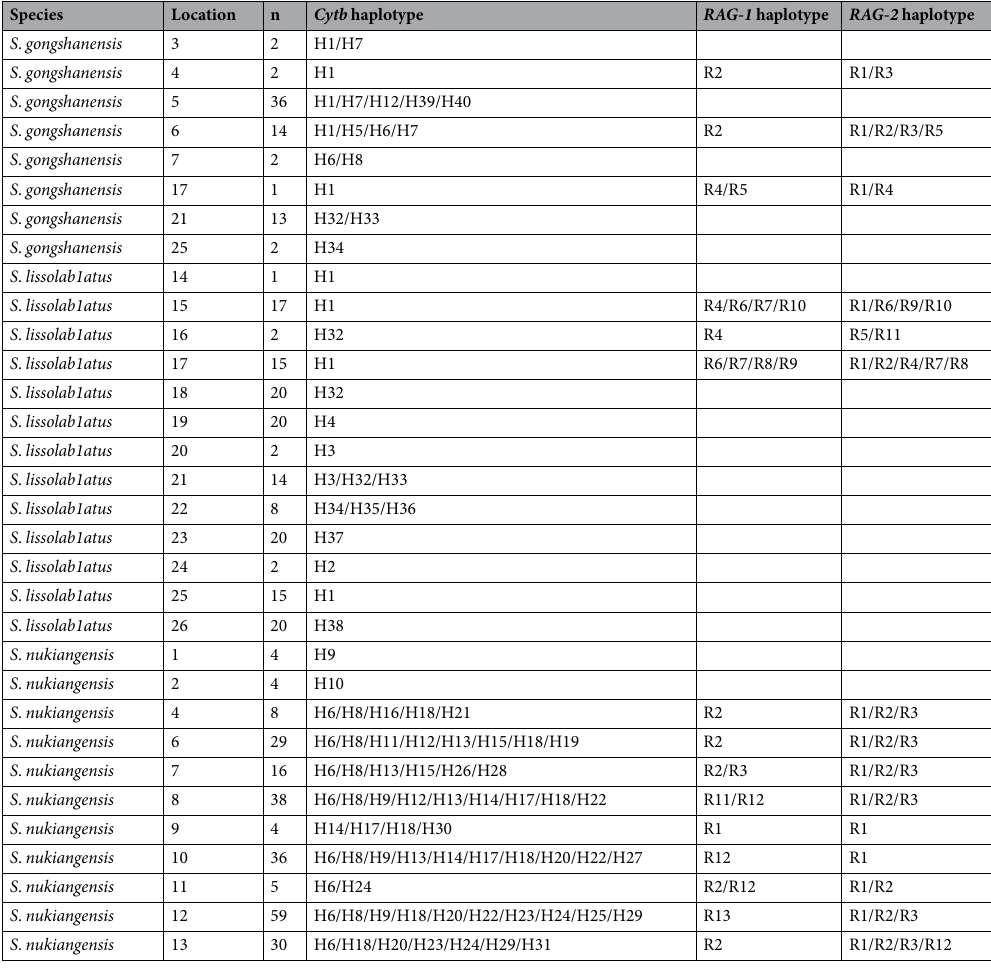
Table 1. mtDNA and nDNA haplotype of the three species in each sampling site. The site numbers are presented in Table S1. n, number of individuals.